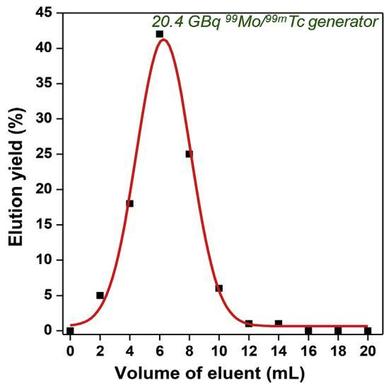
Elution profile of the 20.4 GBq 99Mo/99mTc generator prepared using mesoporous alumina as sorbent.